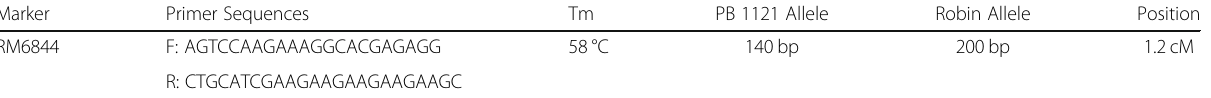
Table 1 Details of SSR marker linked to the AHAS gene which was used in foreground selection